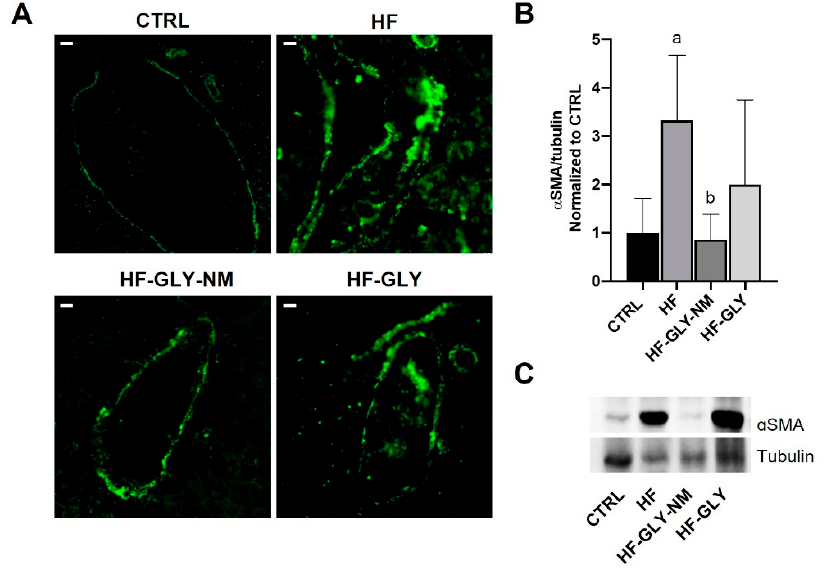
Figure 3. Immunolocalization of α -smooth muscle actin expression ( α -SMA). ( A ) Fluorescent pictures of immunostaining of α -SMA in liver sections from CTRL (Group I), HF (Group VII), HF-GLY-NM (Group IX) and HF-GLY (Group X). Scale bars = 10 µ m. ( B ) Western blot of α -SMA. Values are expressed as a fold change with respect to CTRL ± SD (n = 3). Tubulin was used as the loading control and for band density normalization. Significative values were reported with respect to Group I CTRL, a = p < 0.05; to Group VII HF, b = p < 0.05. ( C ) Representative western blot of α -SMA. (Group I): Control untreated rats allowed free access to food and water; HF (Group VII): rats intraperitoneal injected with CCl 4 three times a week for two weeks; HF-GLY-NM (Group IX): HF rats treated with encapsulated Galunisertib-LY2157299 three times a week for two weeks following CCl 4 injections; HF-GLY (Group X): HF rats treated with free Galunisertib-LY2157299 three times a week for two weeks following CCl 4 injections.